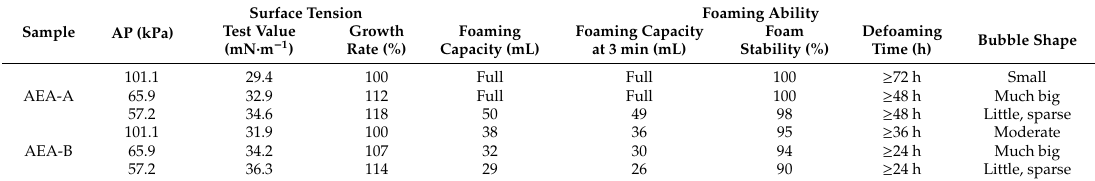
Table 2. Foaming ability of air entraining agent (AEA) under different atmospheric pressures (AP).